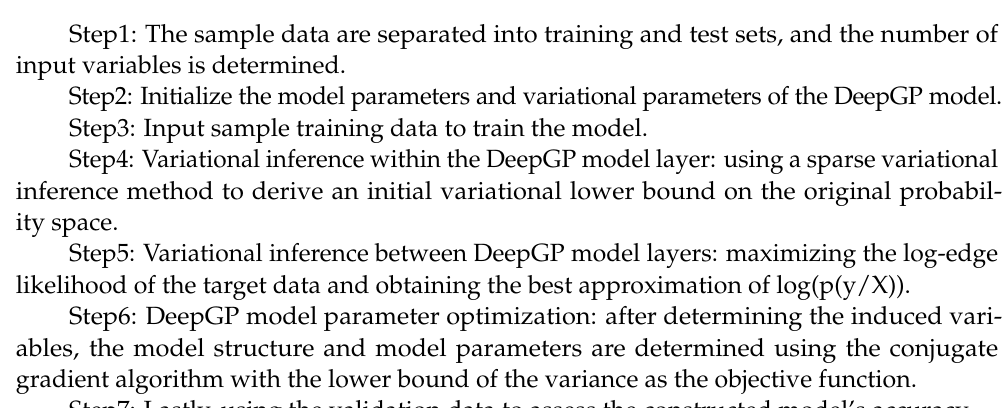
Figure 5. DeepGP model training flow chart.